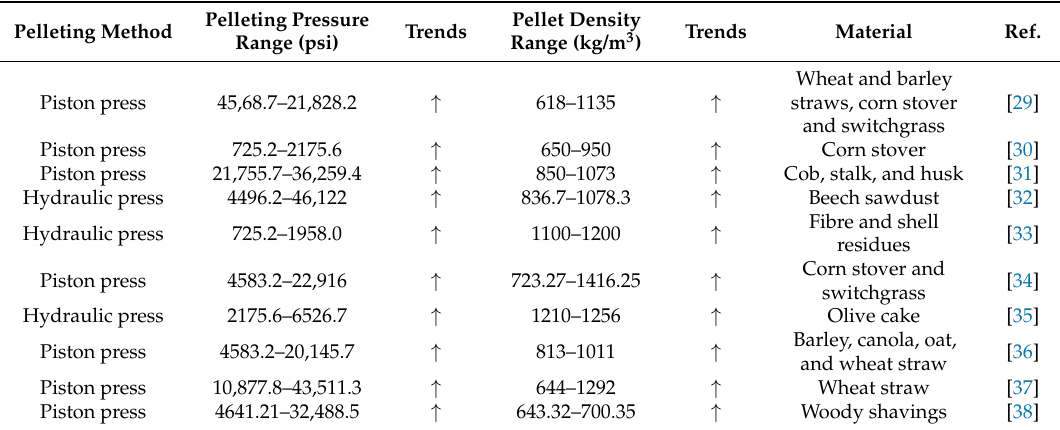
Table 4. The effects of pressure on pellet density by using other pelleting